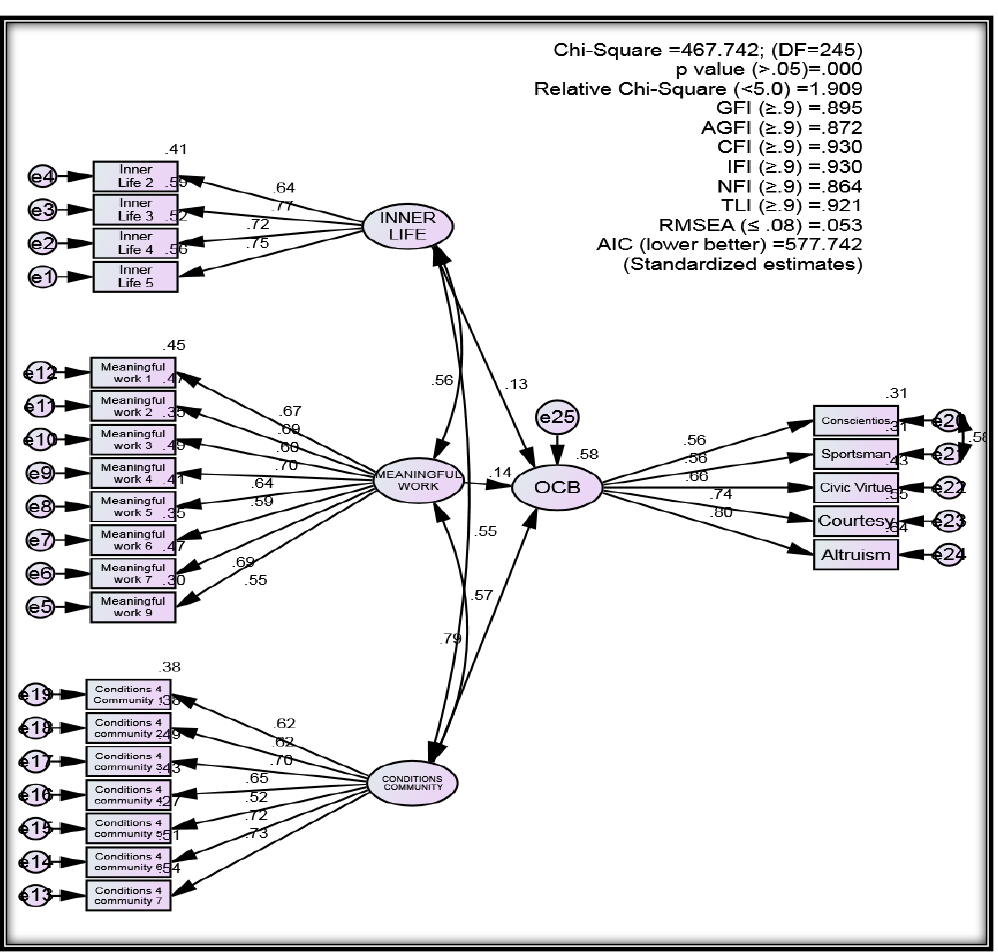
Fig. 3. Structural model of inner life, meaningful work, conditions for community, and organisational citizenship